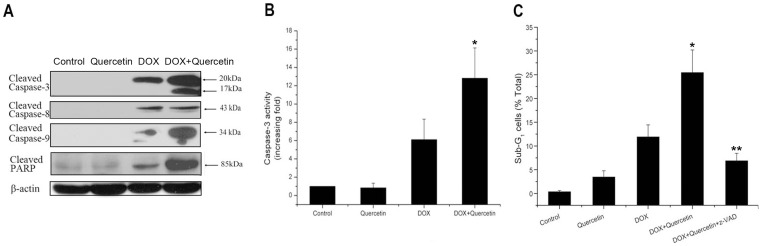
Quercetin enhances DOX-induced caspase activation.(A) Cleaved caspases-3, -8, and -9 and PARP expression were assessed by western blotting in SMMC7721 cells treated with DOX (1 μM) and/or quercetin (20 μM) for 24 hours. β-actin was used as an internal control. (B) Caspase-3 activity assay of DOX- (1 µM) and/or quercetin-(20 µM) treated SMMC7721 cells for 24 h. Cell lysates were incubated with fluorogenic caspase-3 substrate for 1 h at 37°C. Caspase-3 activity was normalized to cell lysate protein and expressed as fold activation compared with the control. *P<0.05 vs. DOX-treated cells. (C) Caspase inhibitor Z-VAD-fmk reduced the effect of quercetin on DOX-induced apoptosis in QGY7701 cells examined by PI staining. Control: 0.5% dimethyl sulfoxide; quercetin: 20 µM; DOX: 1 µM; DOX + quercetin: DOX 1 µM plus quercetin 20 µM; Z-VAD-fmk + DOX + quercetin: cells were pretreated with 25 µM of z-VAD-fmk for 1.5 h and further treated with DOX plus quercetin for 24 h. Data are presented as mean ± S.D. of three independent experiments. *P<0.05 vs. DOX-treated cells. **P<0.01 vs. DOX + quercetin-treated cells.